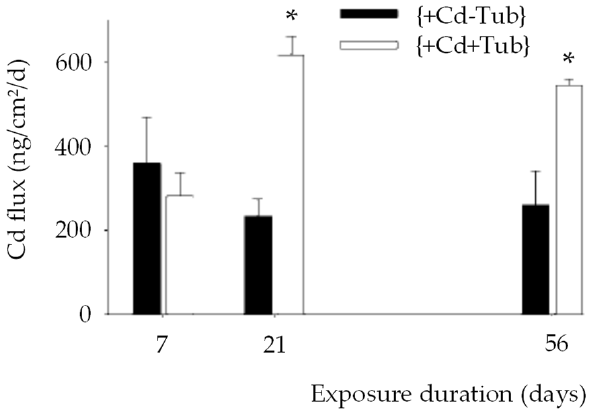
Figure 3. Estimated mean Cd fluxes from the water column to the sediment compartment of experi- mental units for the two experimental conditions: +Cd-Tub, water column contaminated with Cd and no Tubificidae in the sediment; +Cd+Tub, water column contaminated with Cd and Tubificidae in the sediment, over a period of time equal to 7, 21 and 56 d. Mean ± standard deviation (n = 3). * indicates a significant difference between the two experimental conditions ( p < 0.05) [67].